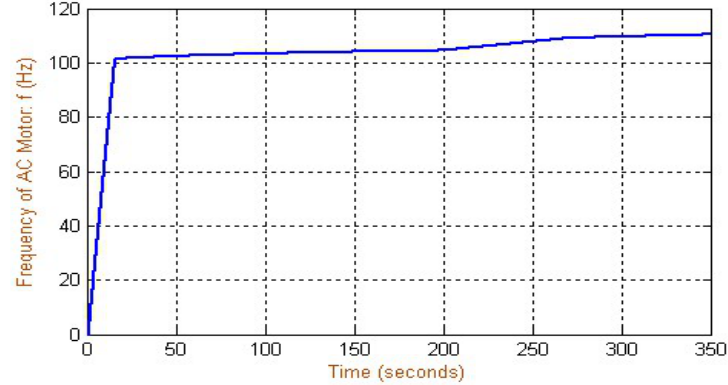
Figure 22. Drive frequency of AC motor versus time.